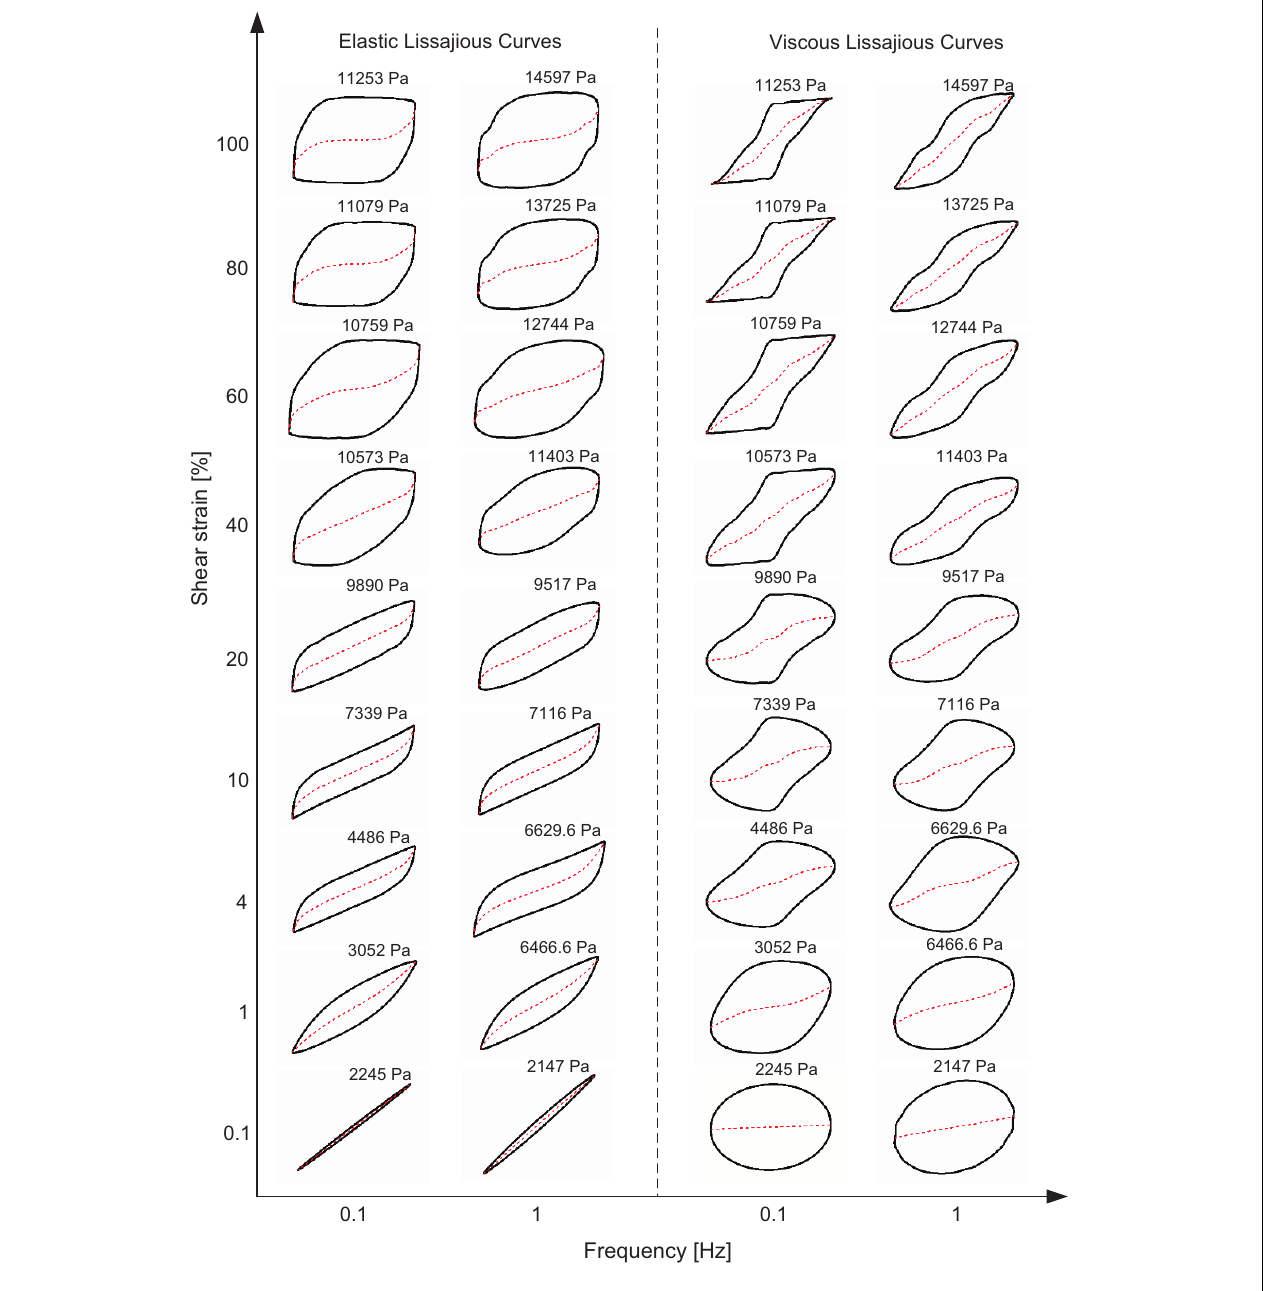
FIGURE 8 | Elastic and viscous Lissajous curves of MRG-70 generated from the strain-controlled oscillatory shear under the magnetic field of 391 kA/m. Each curve is positioned according to the imposed value of shear strain and frequency. The red dash line represents the corresponding decomposed elastic and viscous stress. The value above each curve is the maximum shear stress τ max